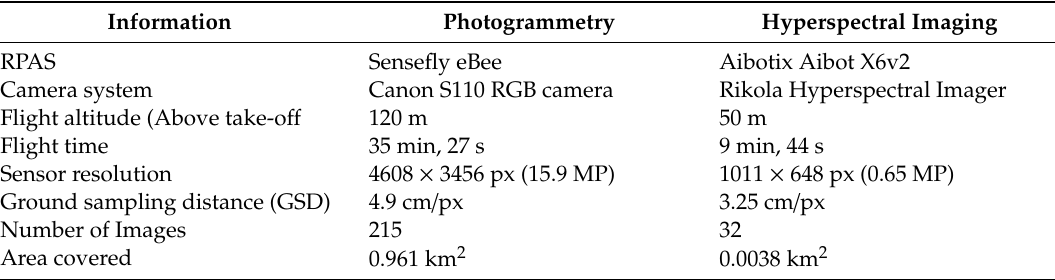
Table 2. RPAS and flight parameters over Area 1,